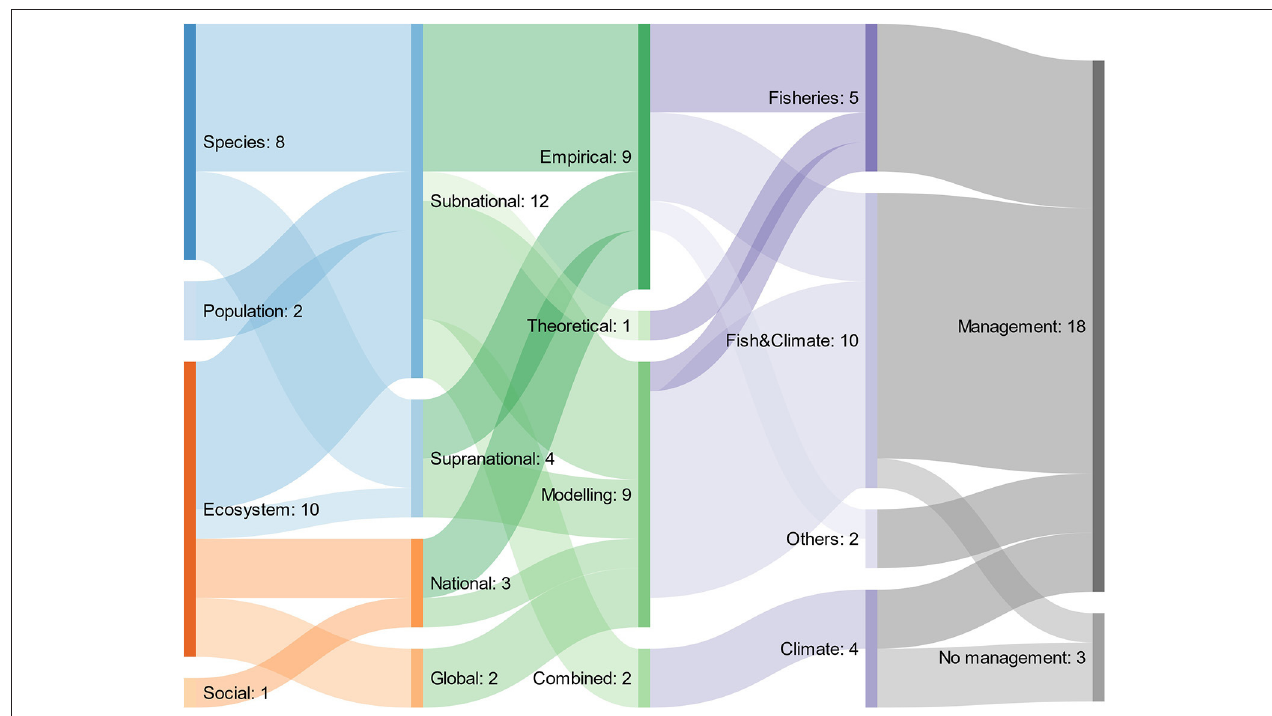
FIGURE 1 | Sankey diagram summarizing the articles contributed to this research topic (source: http://sankeymatic.com/build/). Distribution of articles across (from left to right) level of organization, spatial scale, research approach, type of stressor studied, and whether there was an application to management discussed. Numbers represent the number of papers in each